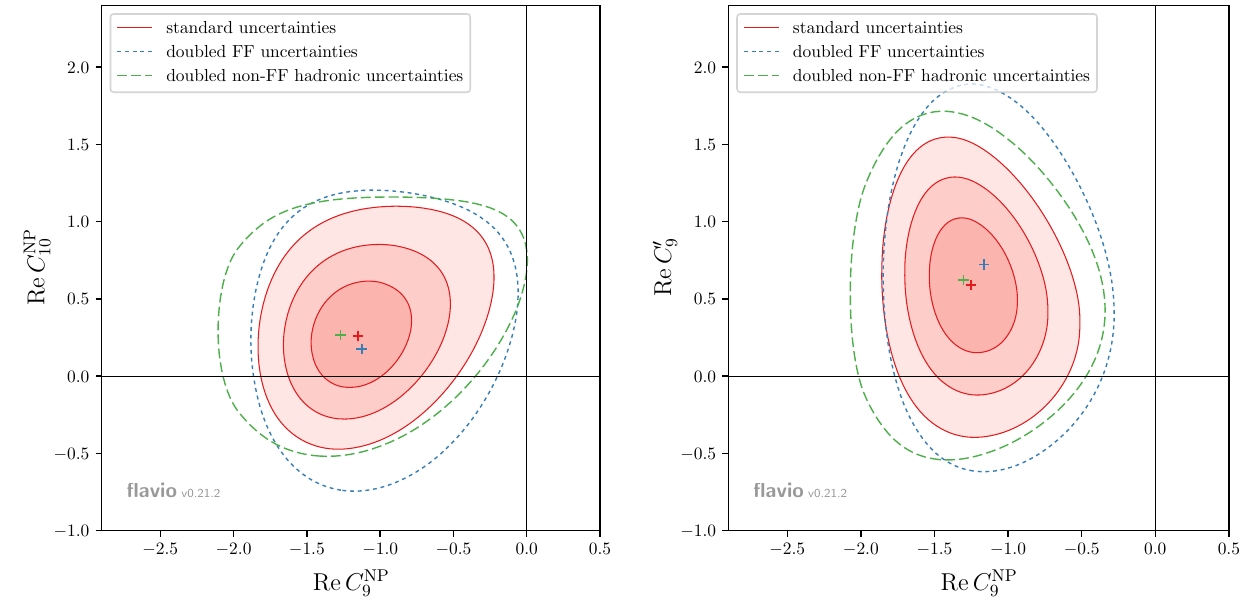
) -Re ( C NP ) plane ( left ) and the Fig. 2 Allowed regions in the Re ( C NP blue short-dashed contours correspond to the 3 σ regions in scenarios 9 10 ) -Re ( C (cid:4) ) plane ( right ). In red the 1 σ , 2 σ , and 3 σ best-fit with doubled uncertainties from non-factorizable corrections and dou- Re ( C NP 9 9 bled form factor uncertainties, respectively. regions with nominal hadronic uncertainties. The green dashed and